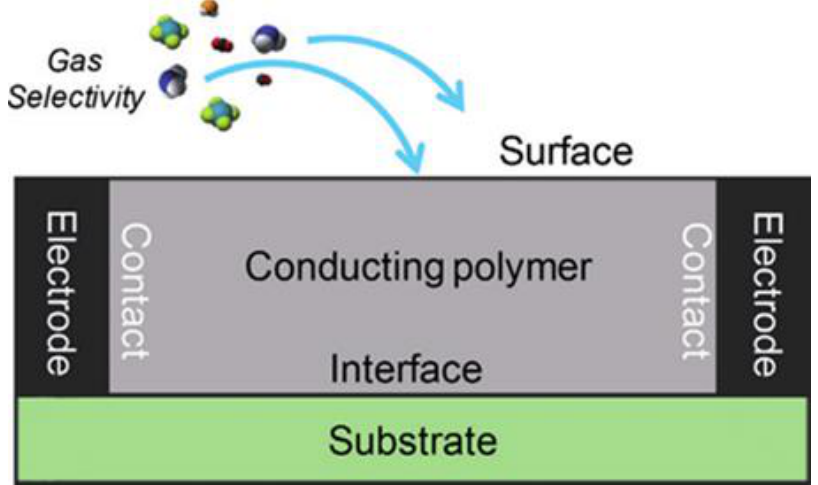
Figure 4. The chemiresistor sensor idea is illustrated schematically for the purpose of selectively detecting chemical sensing materials using chemically sensitive CPs. Reprinted from [27].